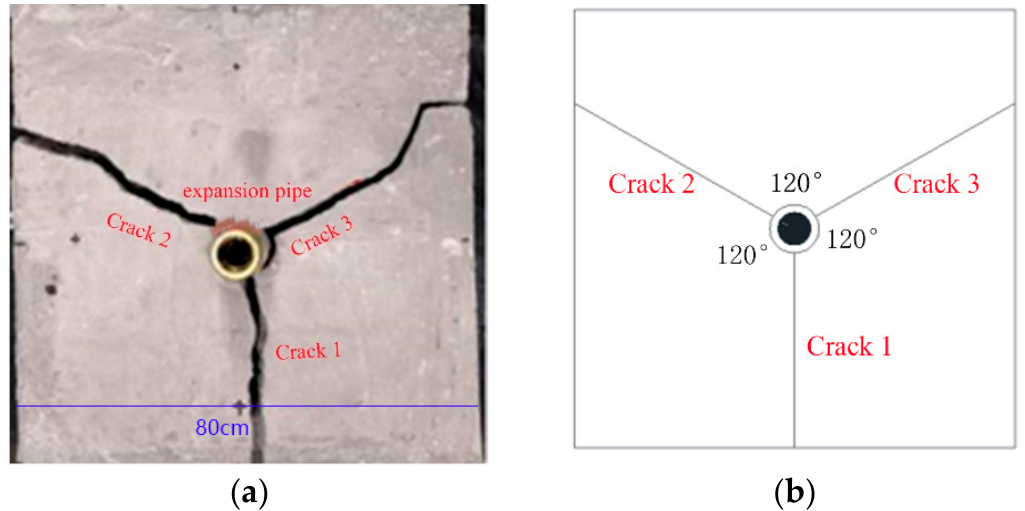
Figure 14. View of crack propagation without constraint. ( a ) Crack propagation diagram; ( b ) Crack sketch diagram.